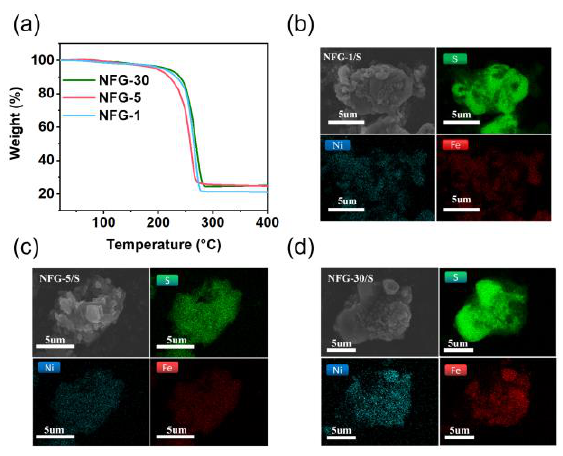
Figure 2. ( a ) TG curves of S@NFG-30, S@NFG-5, and S@NFG-1. Elemental mapping images of ( b